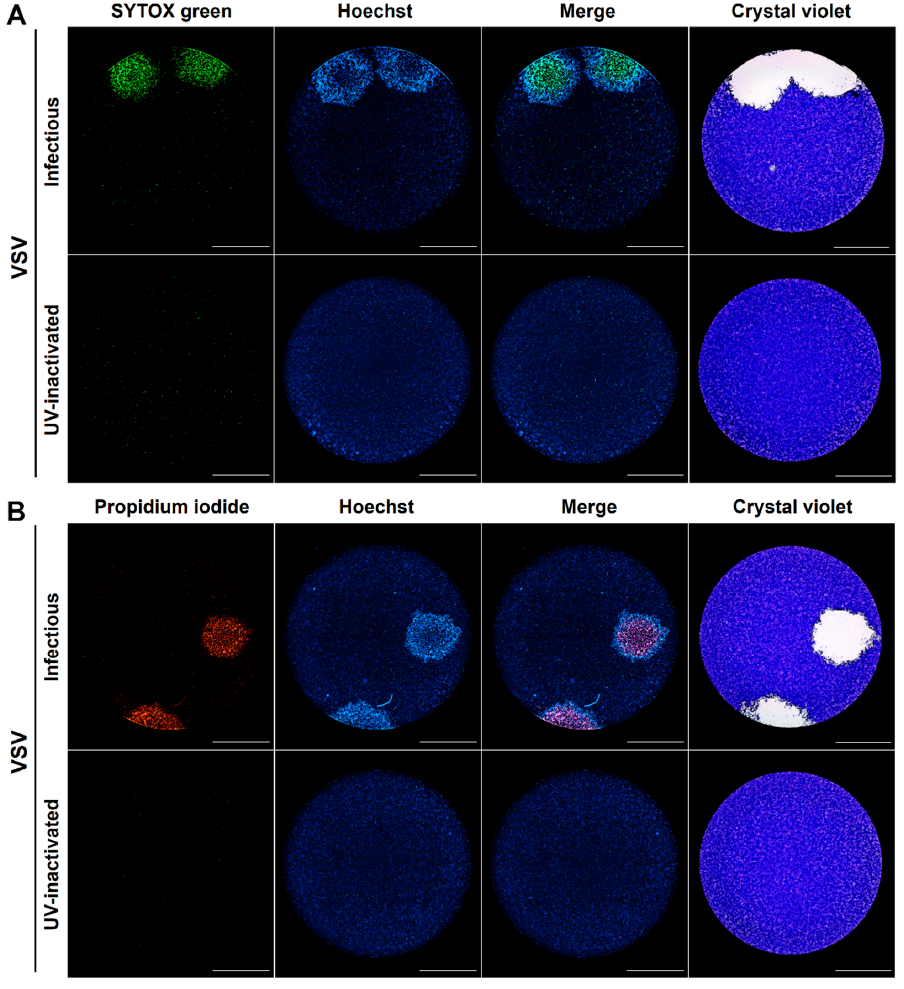
Figure 1. DNA fluorescent dyes with differential cell permeability enable the visualization by live-cell imaging of different stages of virus-induced cytopathic effect at a single-cell and single-plaque level. Vero cells were inoculated with either infectious or UV-inactivated VSV seeds, cell nuclei were stained with Hoechst, and cells were subjected to plaque assay for 72 h with a medium containing the cell death staining SYTOX Green ( A ) or propidium iodide ( B ). After live-cell imaging, acquisition viral plaques were confirmed by the standard crystal violet staining. A representative experiment is shown in each panel (n = three independent experiments), total magnification of 40X, scale bar = 2000 µm.